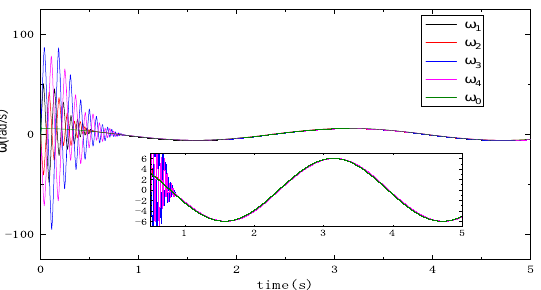
Figure 13. Consensus dynamic tracking curve of all motors under the reference signal θ 0 = 3sin ( 2 t ) : velocity signals of all motors.